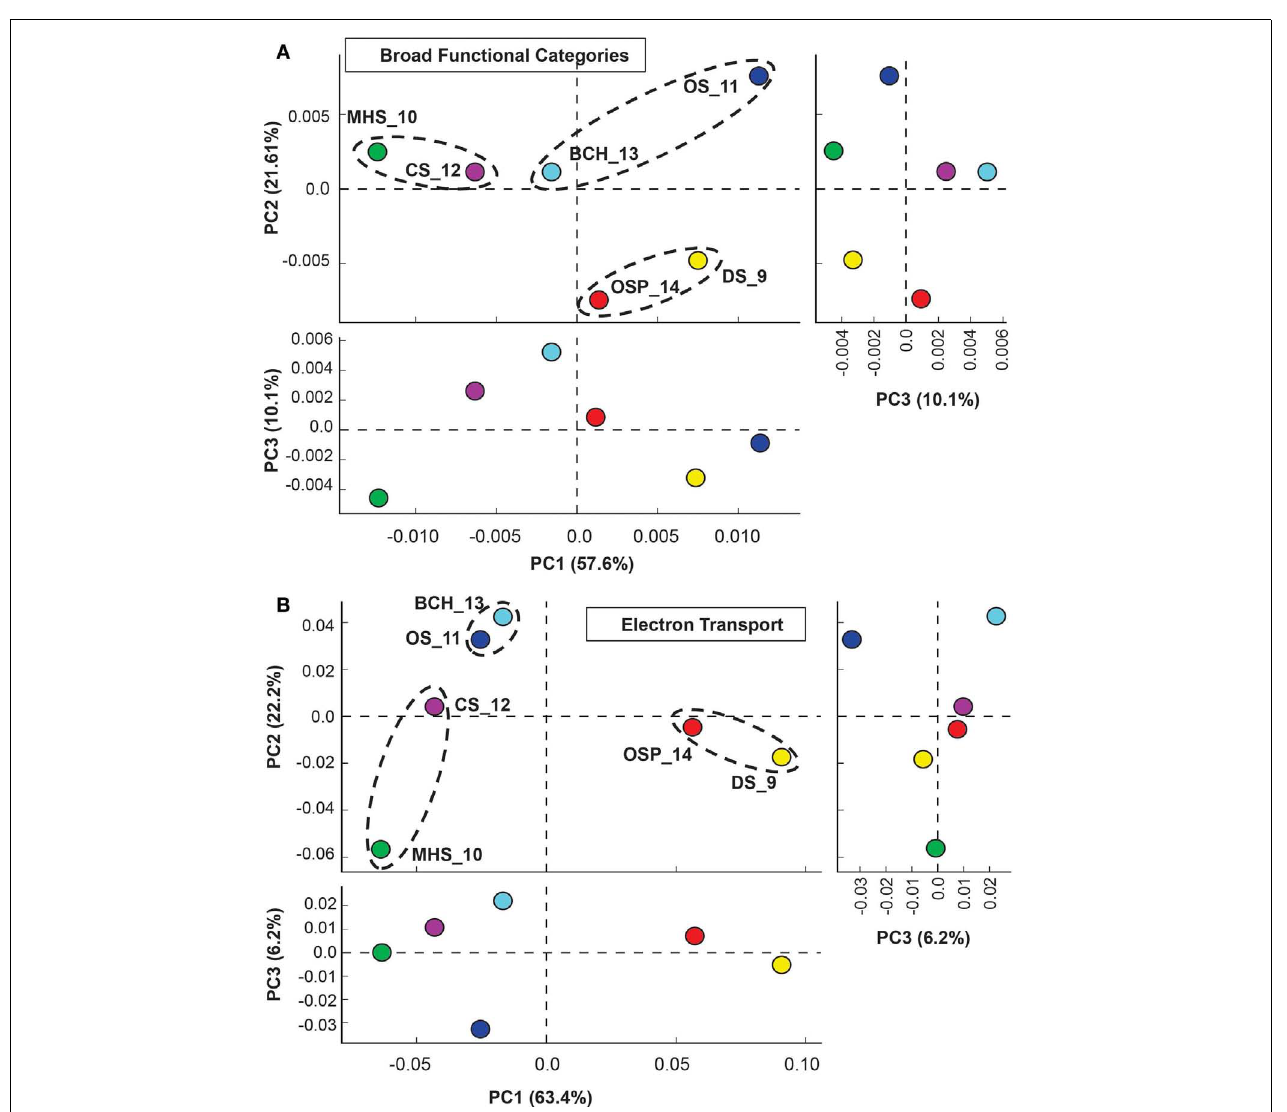
(yellow), OSP_14 (red), MHS_10 (green), CS_12 (violet), OS_11 (dark-blue), BCH_13 (light-blue). Circled sites represent “replicates” that contain one of three dominant Aquificales lineages ( Hydrogenobaculum, Sulfurihydrogenibium , or Thermocrinis